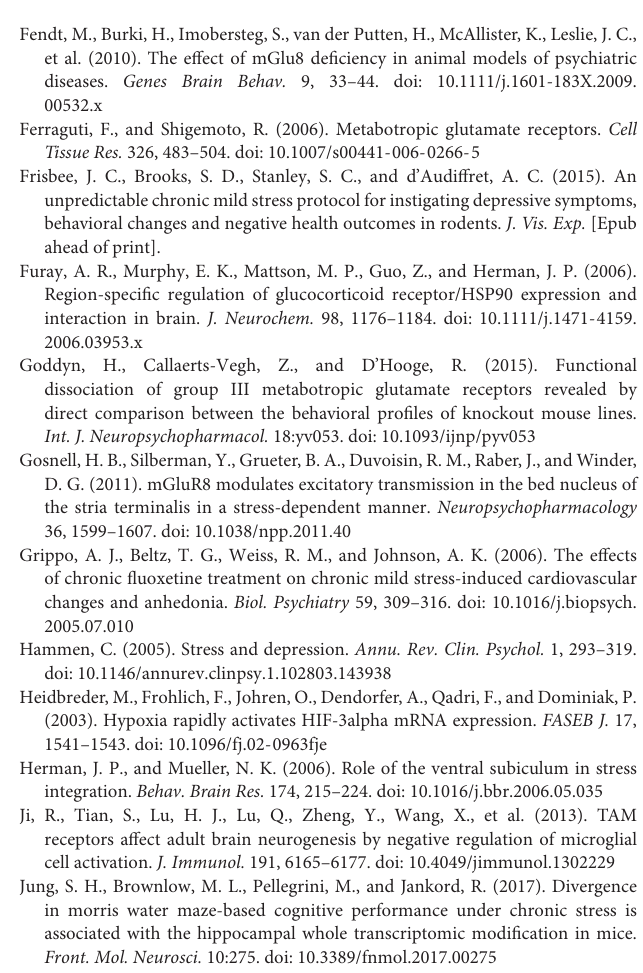
FIGURE S2 | Fecal and Plasma CORT Levels at Time of Tissue Harvest. (A) Baseline fecal CORT levels are shown for each strain. The D strain has high basal fecal CORT. (B) Plasma CORT levels (NH and CMS groups) were collected at tissue harvest and provide baseline (NH) and post-CMS estimates of circulating CORT levels. Plasma CORT levels are significantly higher in CMS treated mice. CMS is associated with significantly higher plasma CORT in the B strain and there is a trend for higher CORT associated with CMS in the D strain. TABLE S1 | Summary of subjects by strain and treatment. TABLE S2 | Body and tissue weight correlations. TABLE S3 | List of transcripts with significant strain or treatment effects. TABLE S4 | Enrichment analysis results for overlapping transcripts among strains. TABLE S5 | Enrichment analysis results for strain-specific